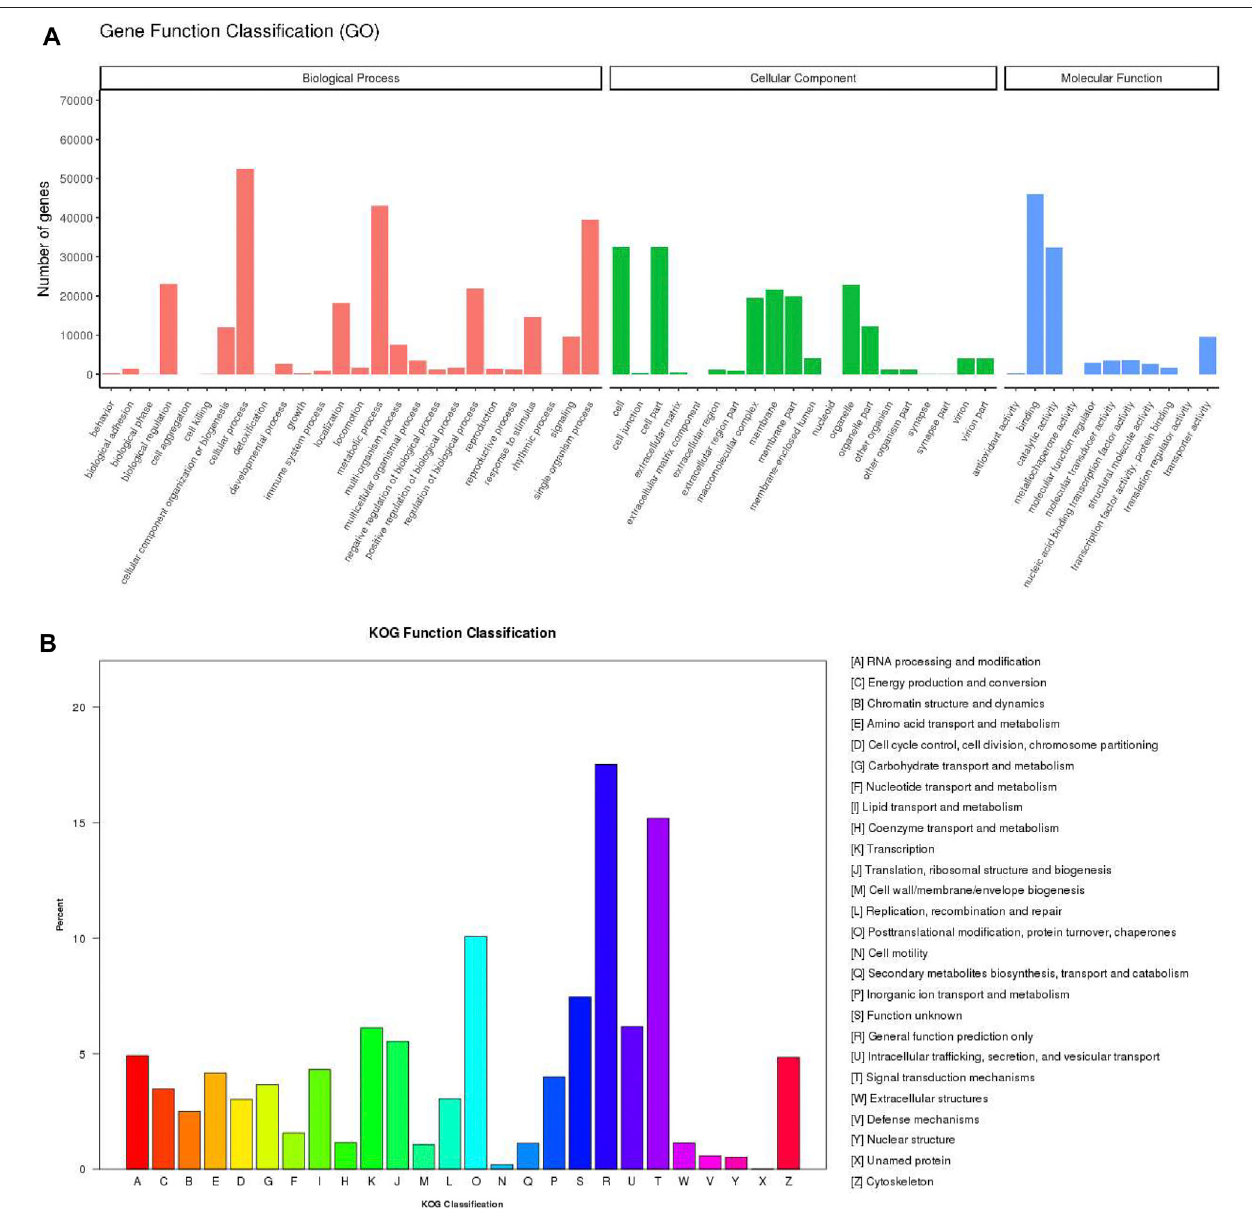
FIGURE2| Annotationofthe P.trituberculatus transcriptome. (A) GOannotationandclassi fi cationofunigenes. (B) KOGannotationandclassi fi cationofunigenes. The x-axis indicates the categories, and the y-axis indicates the number of the unigenes.